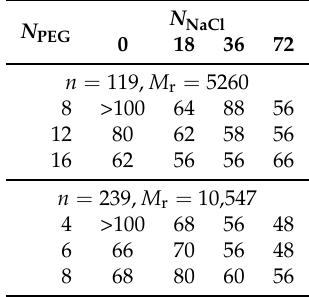
Table 6. Production times (ps) at which the mass transfer of PEG through the plane at z = 20 nm exceeded 500 Da under 1.5 V/nm. N PEG